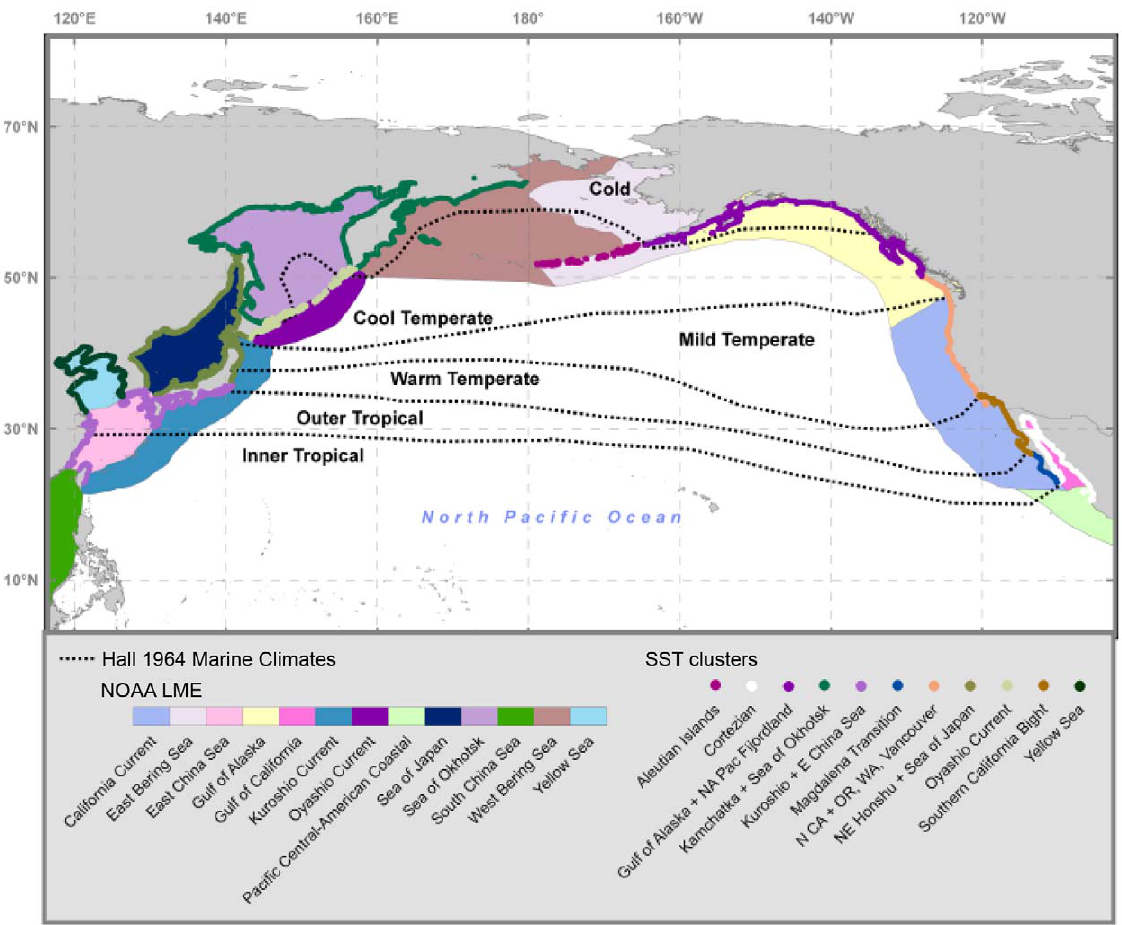
Figure 7. Boundary comparison among the thermal patterns based on our SST cluster analysis, marine climates of Hall [ 40 ] , SST clusters based on cluster analysis, and NOAA’s Large Marine Ecosystems of the World (LMEs). The LMEs are denoted by the outer colored areas. Hall’s marine climates are indicated by the dotted black lines, while the SST clusters derived by clustering MEOW ecoregions by SST are delineated by the inner colored outlines.